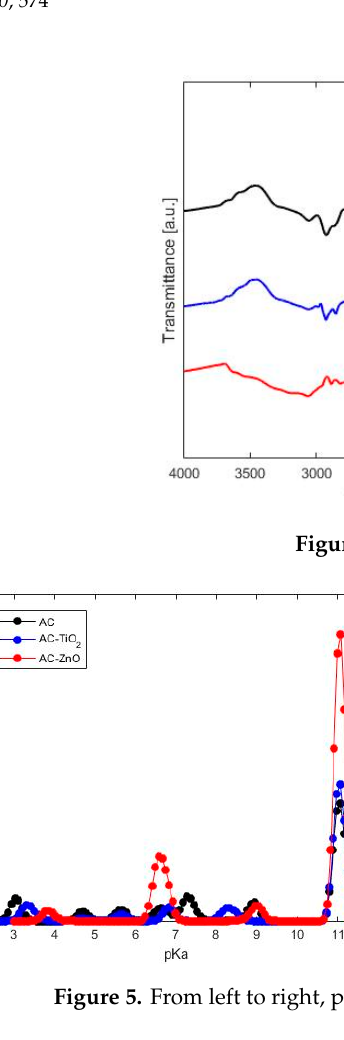
Figure 5. From left to right, pKa distribution and proton binding curves.